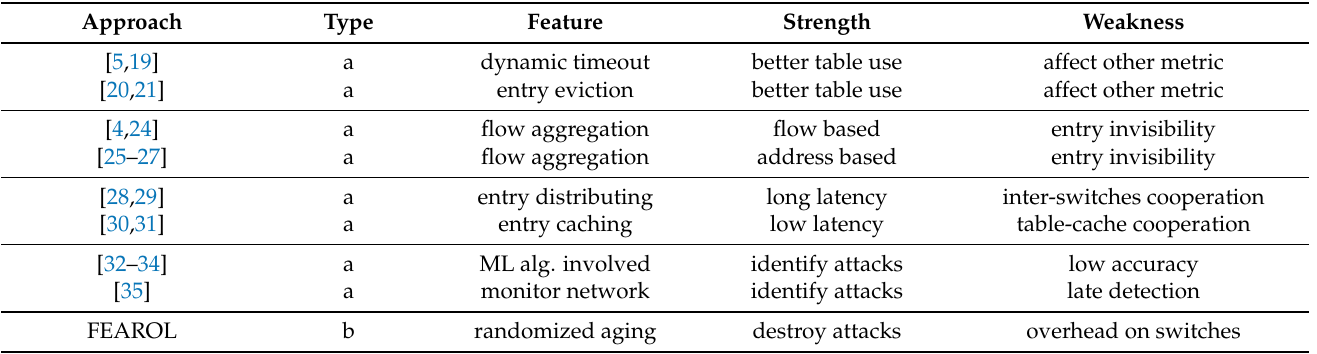
Table 1. Approaches to detect and mitigate flow table overflow LDoS attacks (a—reactive defense and b—proactive